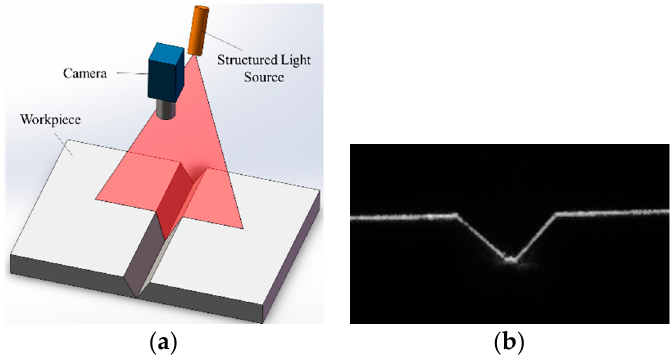
Figure 1. The structured light detection method used in industry. ( a ) The structured light detection method applied to V-groove detection; ( b ) The V-groove image captured by the camera.